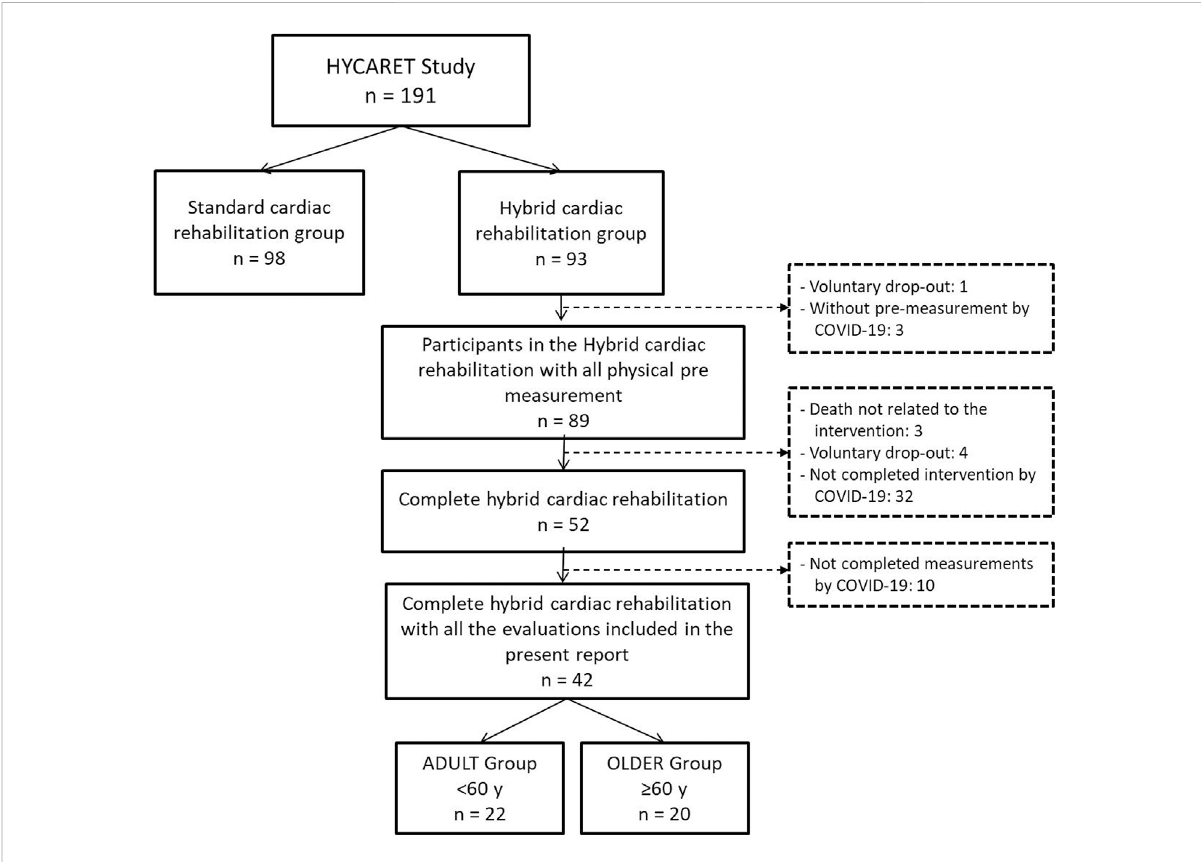
FIGURE 1 Flow diagram of the study